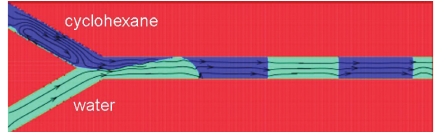
Figure 3: Numerical simulation result for the segment flow in a Y- shaped microchannel at ℎ = 200 𝜇 m, | ⃗𝑢 01 | = | ⃗𝑢 02 | = 0.025 m/s, and = 𝜑 = 30 ∘ . Blue: cyclohexane; green: 𝜑 1 2